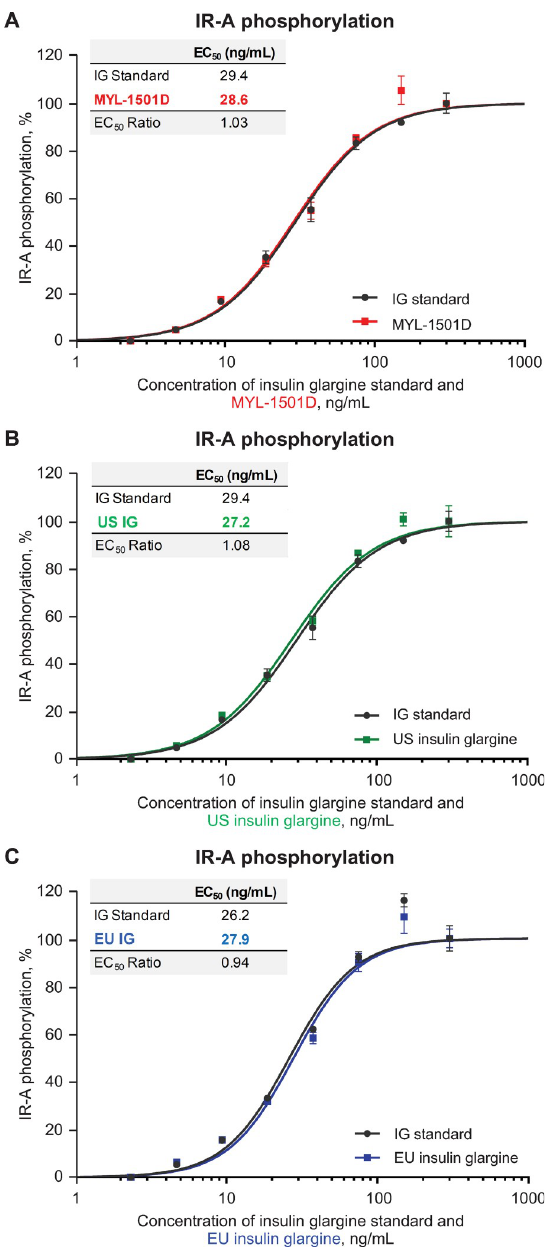
Fig 9. Representative dose-response curves of insulin receptor-A (short-form) phosphorylation assay. Recombinant CHO-K1 Cells Expressing Insulin Receptor-A were used in the assay. (A) MYL-1501D, (B) US-Licensed Insulin Glargine, and (C) EU-Licensed Insulin Glargine. All samples were analyzed against a common insulin glargine reference standard (IG standard) to normalize against day-to-day variability. Each lot was analyzed using 3 independent dilution preparations on an assay plate. Mean ± SEM for the % phosphorylation response is plotted (y- axis) against the concentration (x-axis). Four parameter logistic curve fit was applied to evaluate EC 50 . Each sample was analyzed on 3 independent assay plates, and average is reported. CHO, Chinese hamster ovary; EC 50 , half maximal effective concentration.